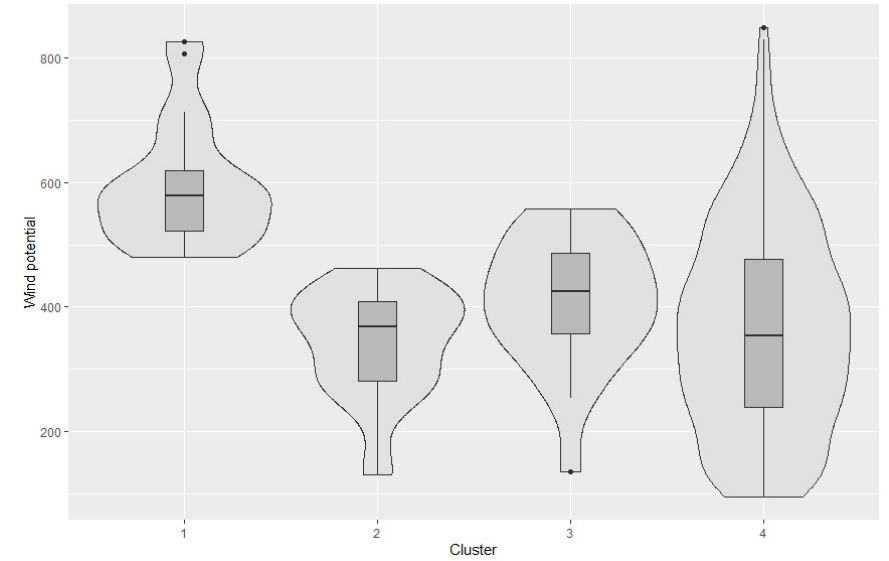
Figure 5. Wind potential distribution for clusters.